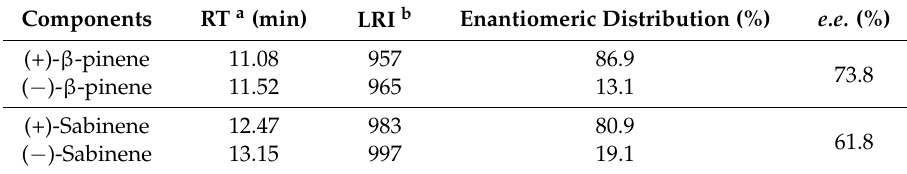
Table 2. Enantiomeric excess of some essential oil constituents from Niphogeton dissecta .